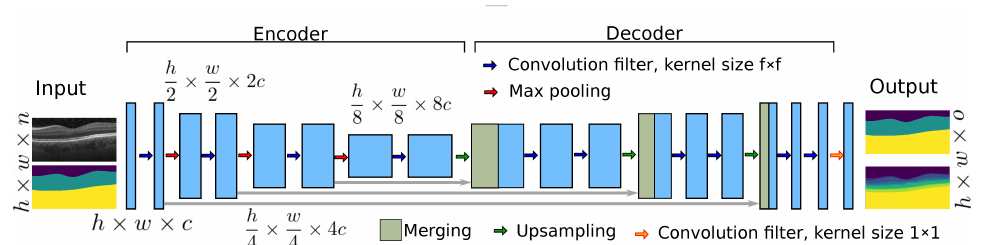
Figure 3. The general architecture of the proposed compressed U-Net. RS-net and IS-Net both have the same architecture with different channel depth c , kernel size f , number of input channels n and number of output classes o .